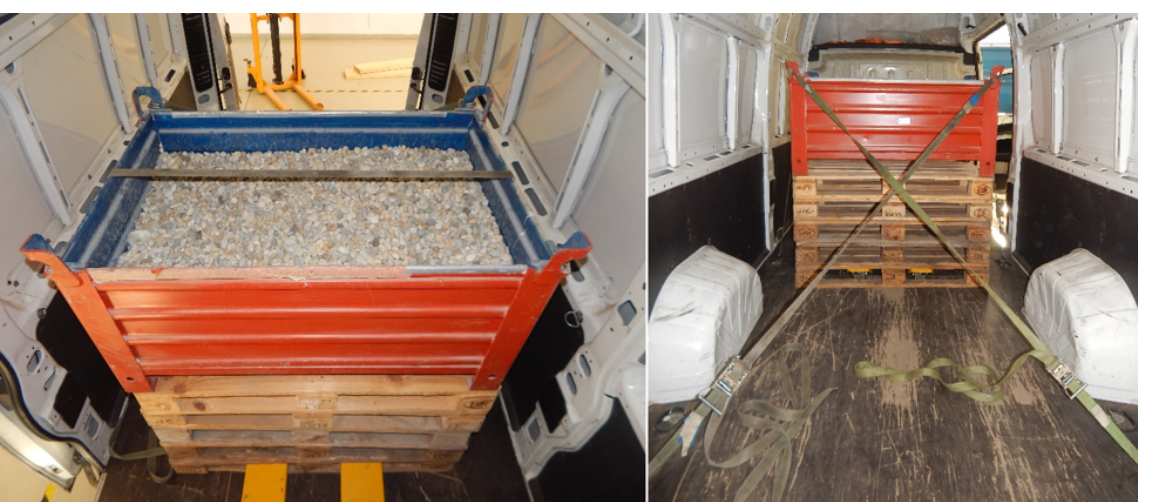
Figure 4: Securing of the 500 kg load with high COG. Source: